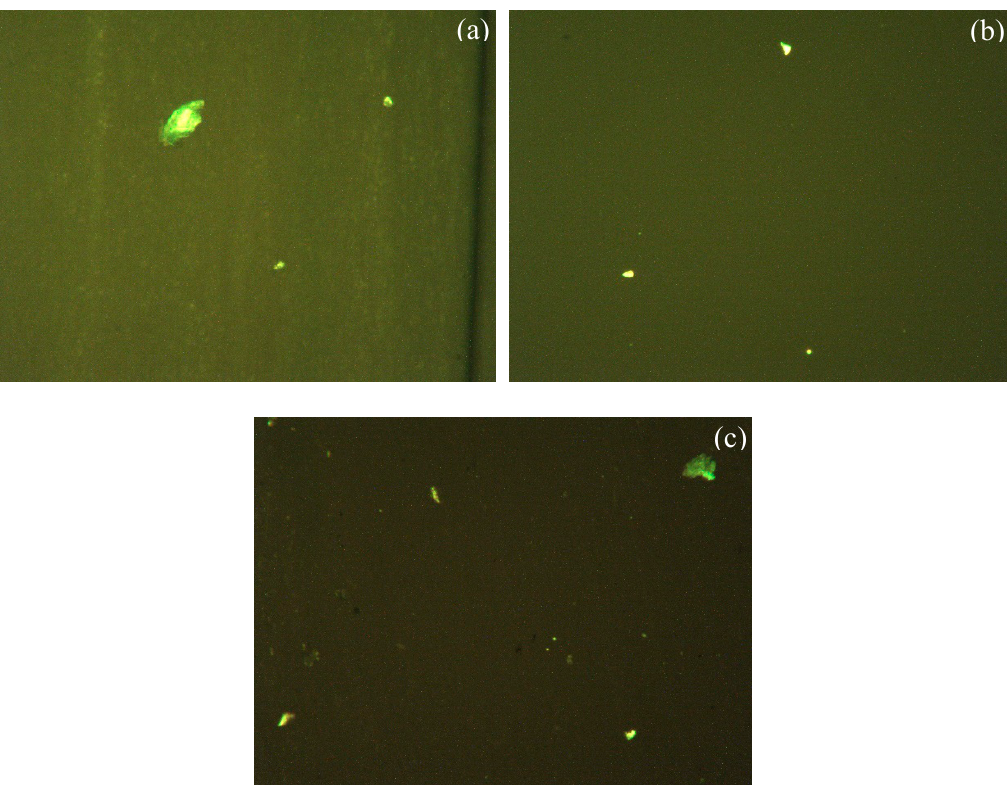
Figure 14. FM pictures of bitumen from TL-UL, TL-ML, and TL-BL (100 × ): ( a ) TL-UL; ( b ) TL-ML; and ( c ) TL-BL. 288